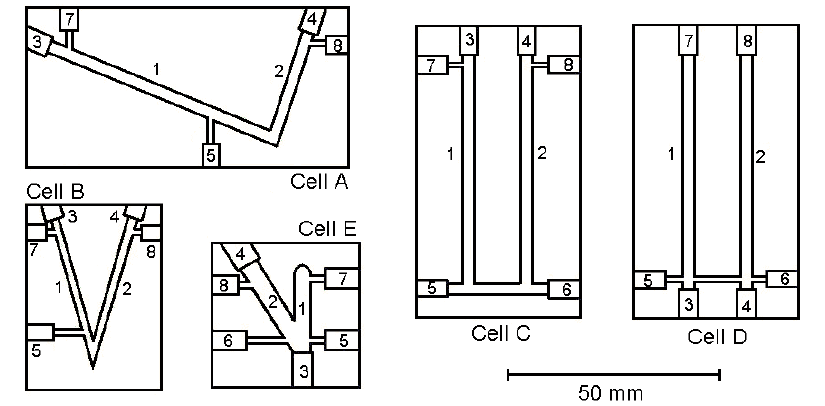
Figure 1. New flow-through electrolytic cells: 1 – cathode chamber, 2 – anode chamber, 3 – cathode holder, 4 – anode holder, 5, 6 – electrolyte inlet (pure or containing analyte), 7 – outlet to gas-liquid separator, 8 – waste